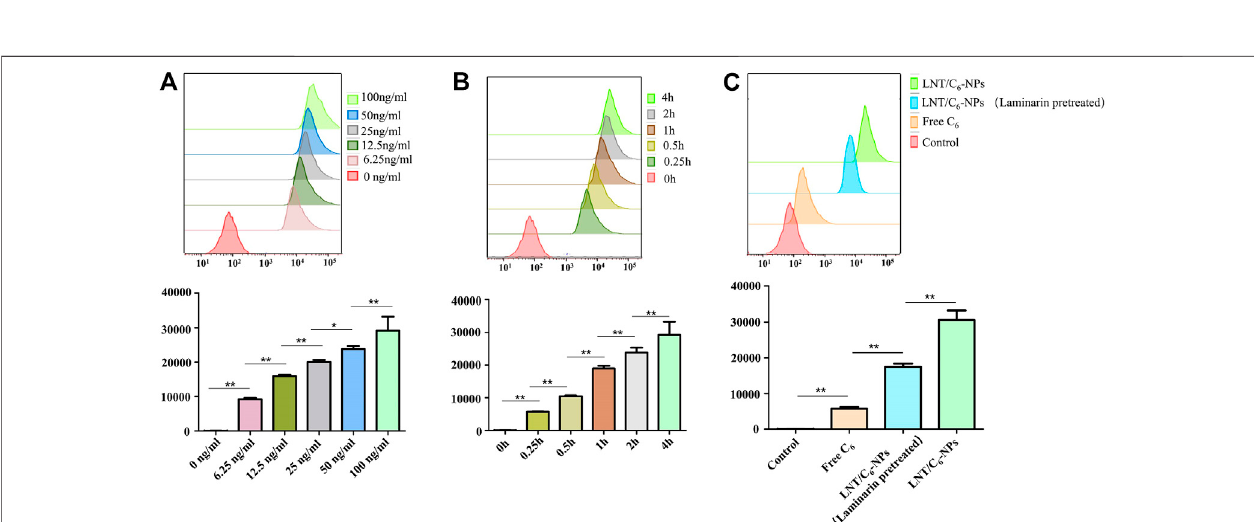
FIGURE 3 | Quantitative analysis of macrophage cellular uptake capacity to different C 6 formulas. (A) Quantitative measurement of LNT/C 6 -NPs uptake by Raw264.7macrophagesafterincubationfor4 hatdifferentconcentrations(6.25,12.5,25,50,and100 ng/ml). (B) QuantitativemeasurementofLNT/C 6 -NPsuptakeby Raw264.7 macrophages at different incubation times (0, 0.25, 0.5, 1, 2, and 4 h) with a C 6 concentration of 100 ng/ml. (C) Quantitative analysis of macrophage cellular uptake capacity to Free C 6 and LNT/C 6 -NPs. * p < 0.05; ** p < 0.01, n (cid:1) 3.